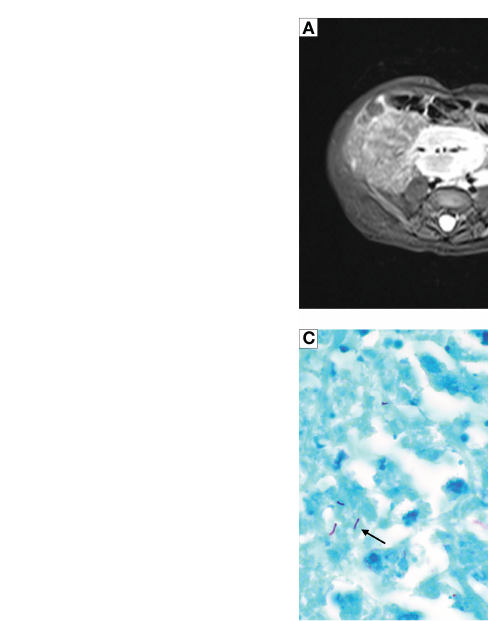
FIGURE 3 Patient 2 imaging and autopsy fi ndings. (A) Abdominal MRI with lymphadenopathy surrounding mesenteric vessels. (B) H&E staining of a lymph node showing a caseating granuloma and giant cells. (C) Acid-fast staining of lymph node tissue showing presence of mycobacteria (arrows). (D) Cultured thymus tissue at time of autopsy. H&E staining shows intact Hassall bodies (arrow) surrounded by numerous thymocytes. The cultured thymus tissue graft was implanted in the quadriceps muscles. Muscle tissue is visible adjacent to the cultured thymus